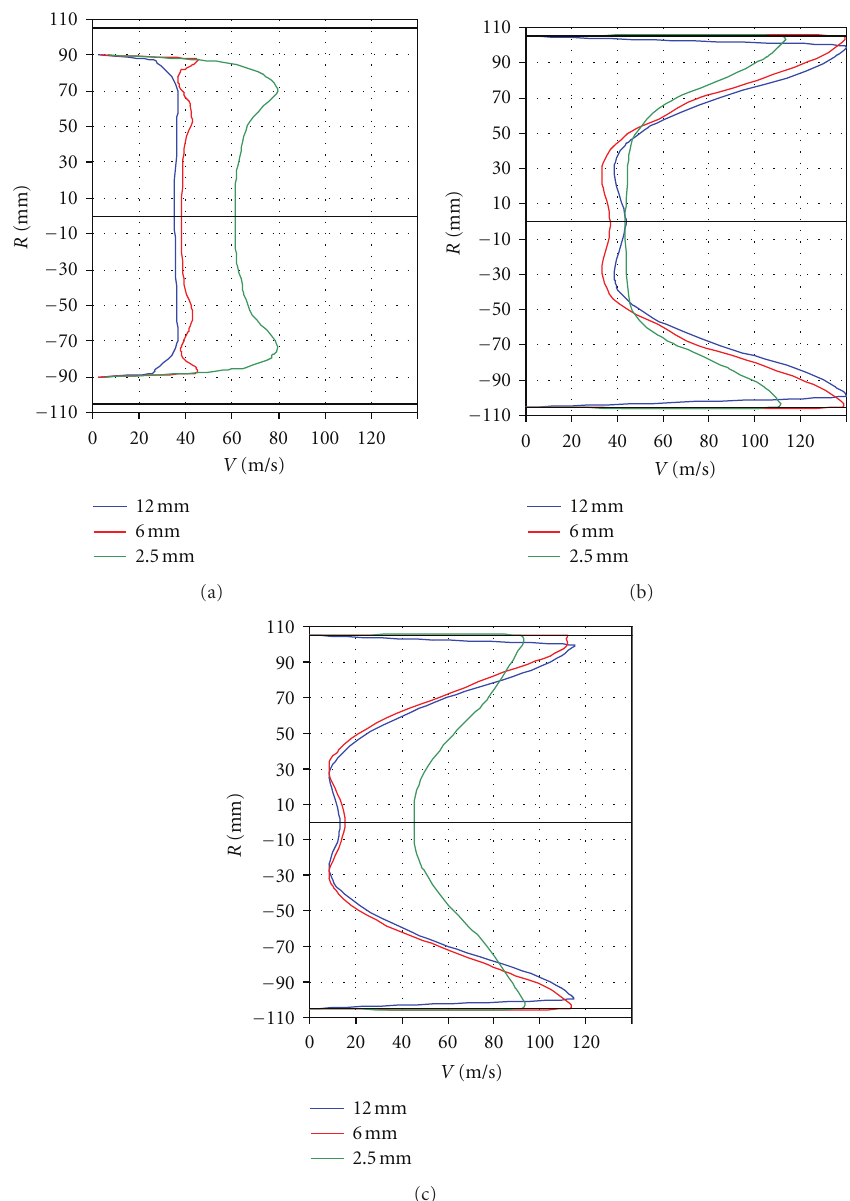
Figure 9: The total velocity V distribution in the cross-sections ( X = 2 mm, 500mm, and 1000 mm).